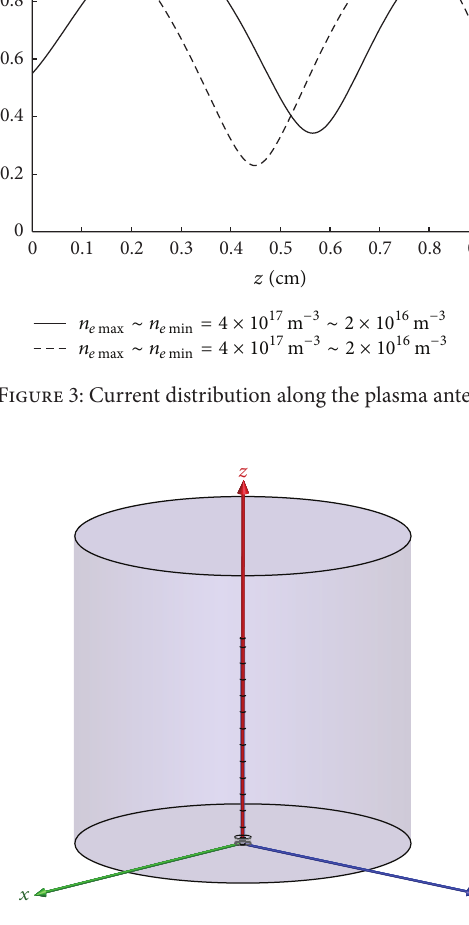
Figure 4: HFSS model of the plasma antenna with 13